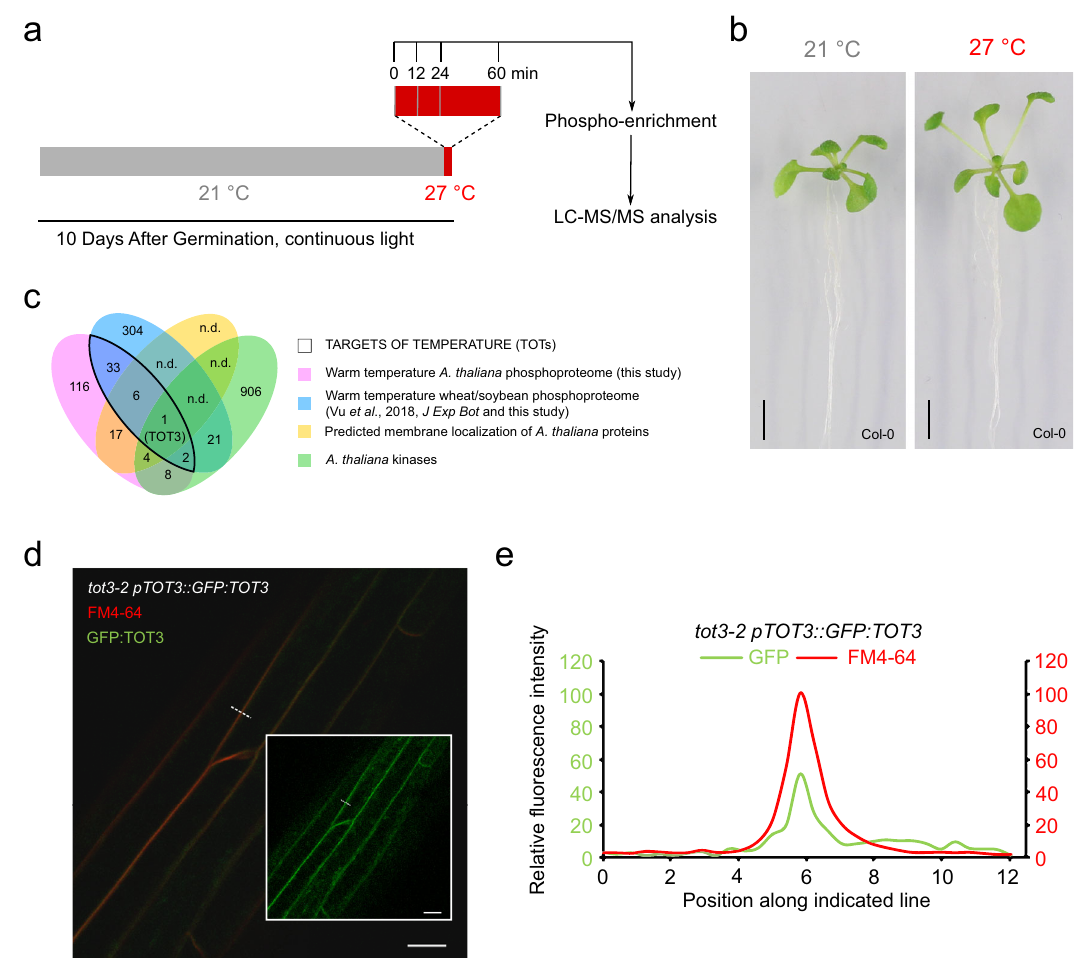
Fig. 1 Phosphoproteome pro fi ling reveals TOT3/MAP4K4 as a potential regulator of thermomorphogenesis in Arabidopsis. a Schematic overview of the experimental setup. b Representative seedlings subjected to the experimental setup, after 3 days of exposure to 27 °C. Scale bar, 5 mm. c Venn diagram comparing datasets to de fi ne TARGETs OF TEMPERATURE (TOTs), and speci fi cally TOT3. n.d., not determined (plasma membrane localization only predicted for candidates from A. thaliana experiment). Kinases based on ref. 73 . d , e Merged red and green signals of localization of GFP:TOT3 (green) in the etiolated hypocotyl of tot3-2 seedlings expressing pTOT3::GFP:TOT3 seedlings grown at 28 °C and stained with the endocytic tracer dye FM4-64 (red) ( d ). Inset in ( d ) shows GFP:TOT3 signal alone. Quantitation of relative fl uorescence intensity at 493-532 nm (GFP) and 596-645 (FM4-64) along dotted white line ( e ). Scale bar, 20 µ m ( d